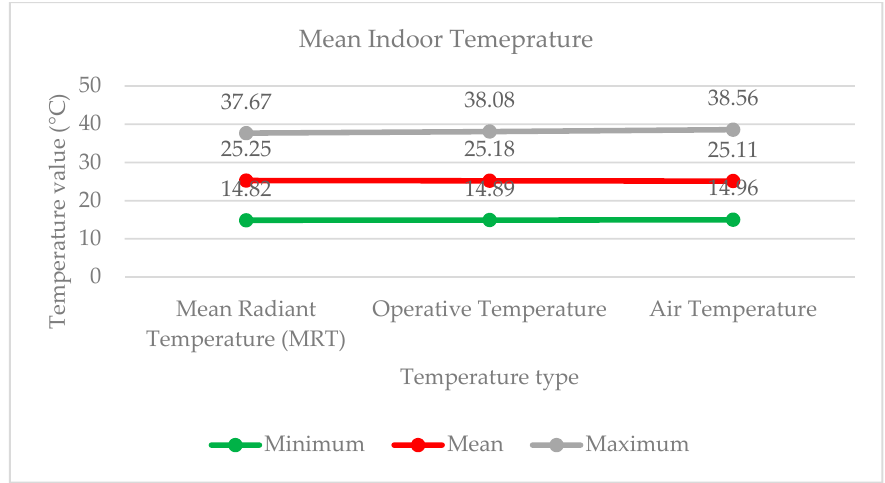
Figure 17. Indoor temperature analysis of the base ‐ case building, where the gray line presents the maximum, red line presents the mean and the green line presents the minimum values.